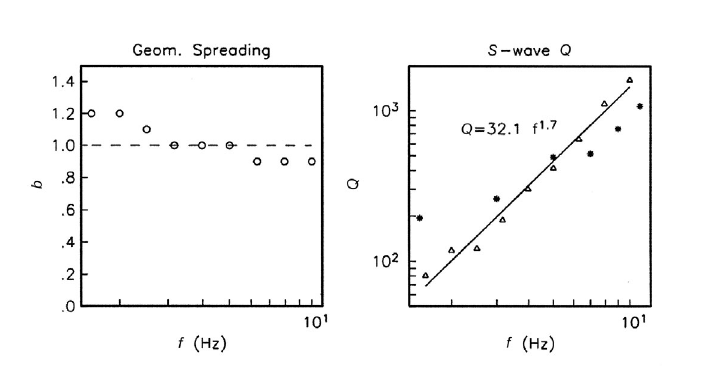
Fig. 8. Left frame shows the values of the exponent b obtained for the geometrical spreading function assumed (see eq. (4.1)). The right frame shows the estimates of the quality factor Q- of the S -waves (triangles) as func- tion of frequency. The asterisks are the values of coda Q reported by Bianco et al. (2002) for the Southern Apen- nine